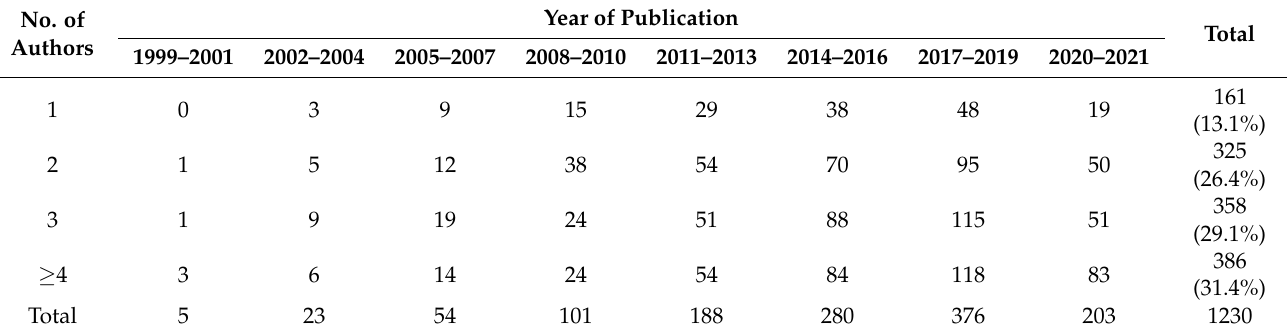
Table 7. Distribution of publications by year and number of